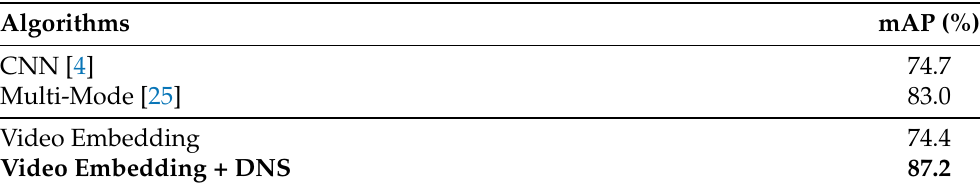
Table 1. Event detection performances of our continuous video semantic embedding model compared with the model integrated with discriminative negative sampling (DNS) on the MED11 dataset.